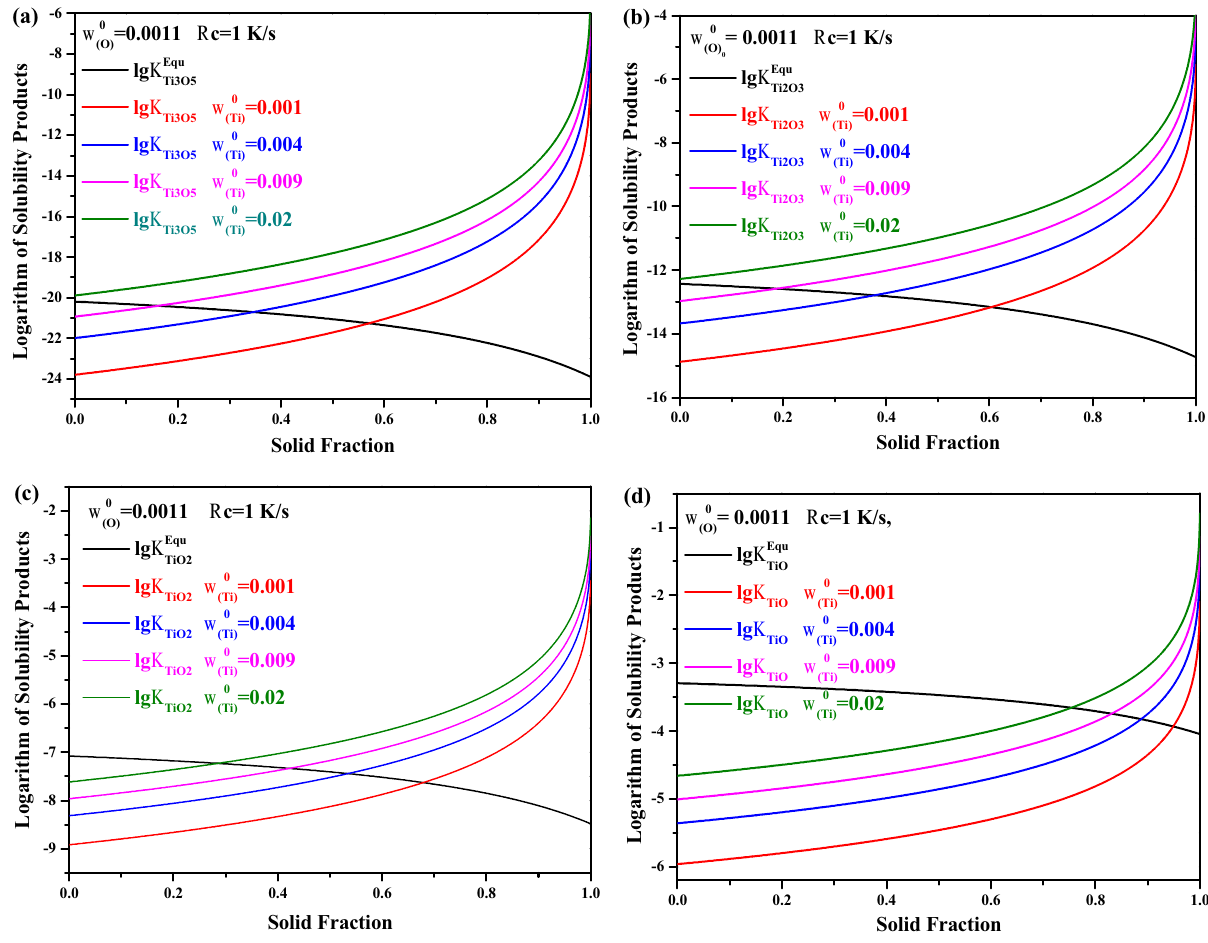
Figure 8: Effects of solute element Ti on the precipitation time of Ti – O compounds at the cooling rate of 1 K/s. ( a ) Ti 3 O 5 , ( b ) Ti 2 O 3 , ( c ) TiO 2 , and ( d ) TiO.